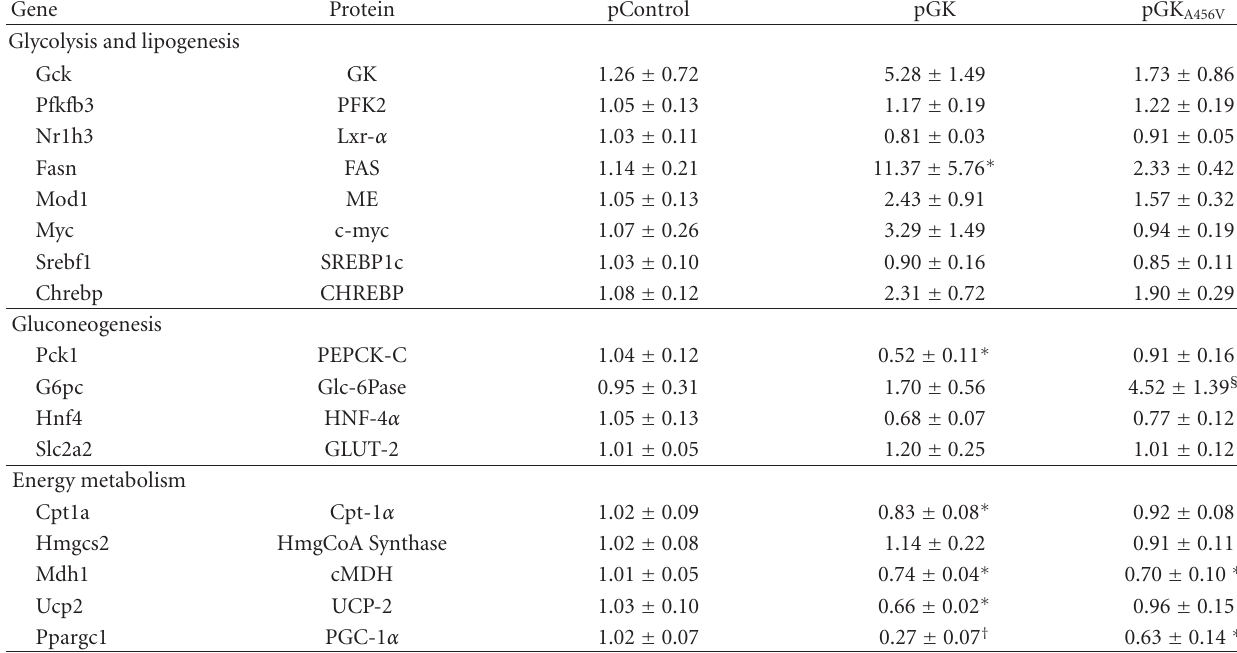
Table 2: Gene expression profile in livers of diabetic mice after a short